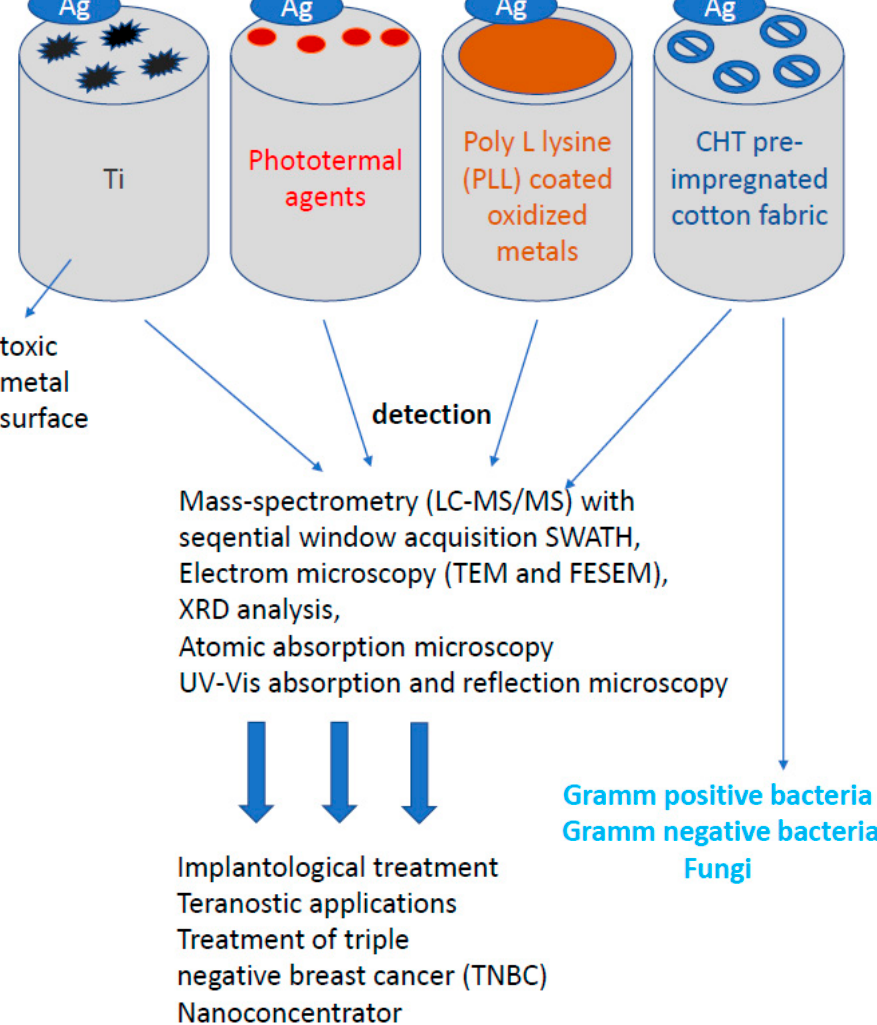
Figure 8. Other properties of silver nanoparticles. Despite the wide anisotropic and anti-inflammatory properties of silver nanoparticles (AgNP) in the human body, silver, in addition to its widespread use on bacterial or fungal cells, also plays an extremely important role in bioengineering. A new approach to the use of silver nanoparticles was their use in skin and epithelial diseases. Since diseases of the skin and epithelium occurring in intimate places are still a difficult topic, new solutions and methods of wound treatment are being intensively searched for, in particular, the creation of an ideal dressing. A dressing intended for the treatment of chronic wounds, such as burns and diabetic wounds, should be effective against exudates and provide a microenvironment conducive to repair processes. In the case of critically colonized wounds, the dressing should penetrate the biofilm and reduce pathogens. Tests carried out on AgNPs confirm the possibility of penetration of particles into the biofilm layer [38,62,74,78,80,81], which is extremely important when fighting the source of infection or colonized spaces [97,111,112,152–162]. There are